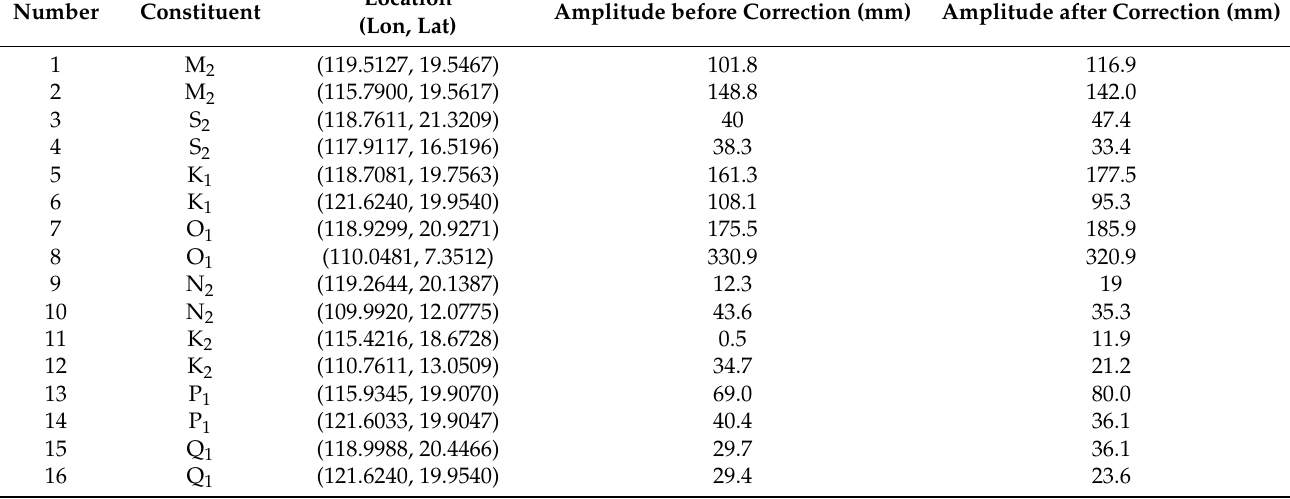
Table 5. Altimeter-based tidal estimates at selected